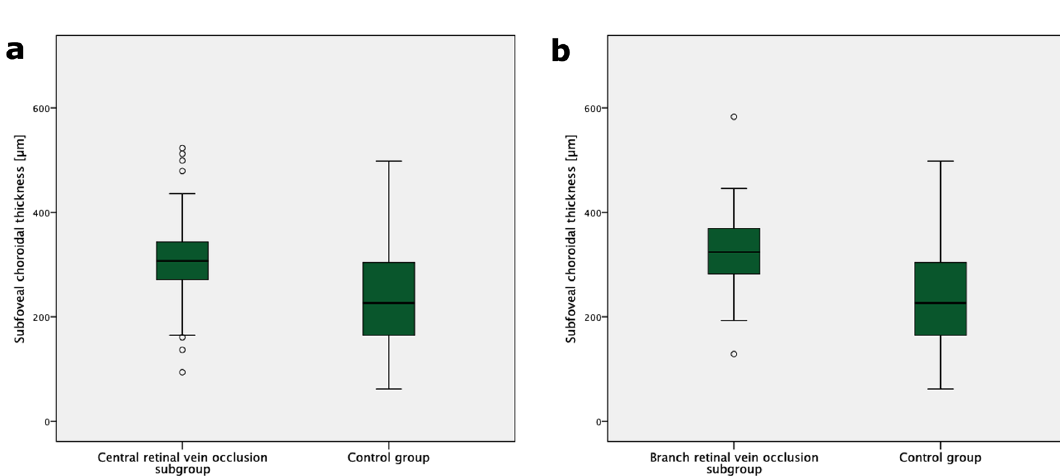
Figure 4. SFCT in the CRVO and BRVO subgroups and the control group. Boxplots showing significantly increased SFCT in the CRVO ( a ) and BRVO ( b ) subgroups compared with the control